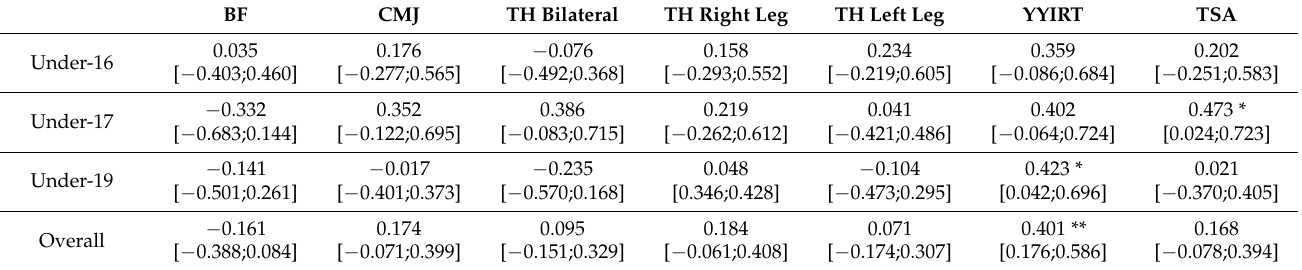
Table 3. Correlation table between time of play (min) with the remaining physical fitness